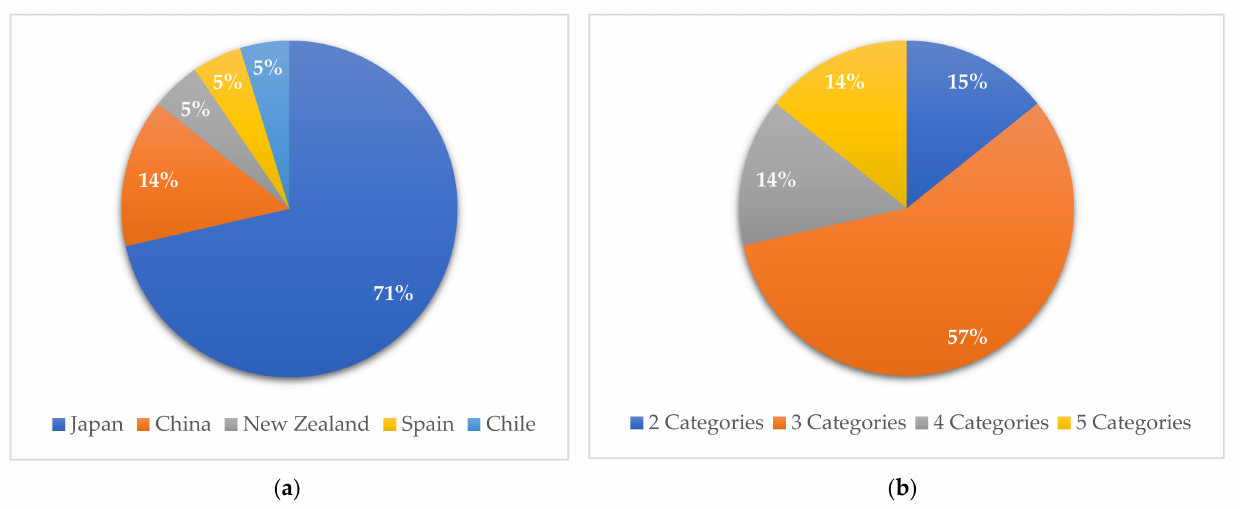
Figure 3. ( a ) Percentile distribution of the reviewed articles by country; ( b ) eating speed categories in the reviewed articles by